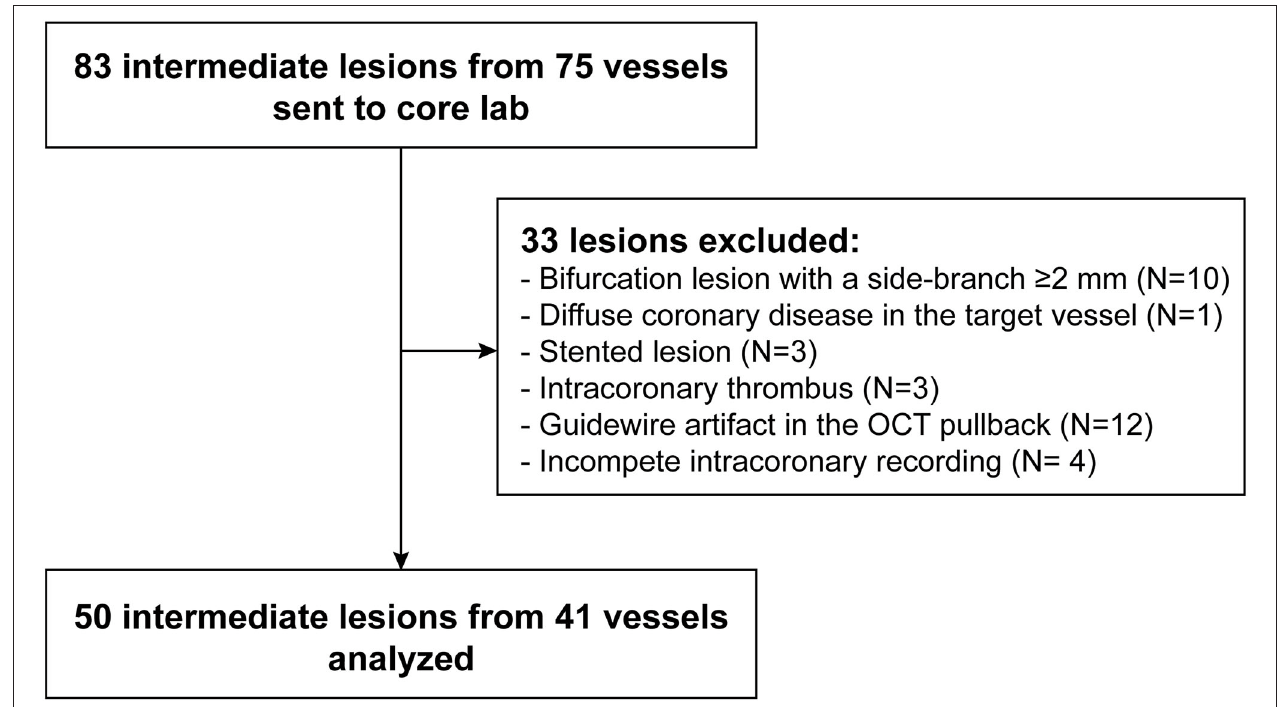
FIGURE 2 | Study flow chart. FFR, fractional flow reserve; OCT, optical coherence tomography.